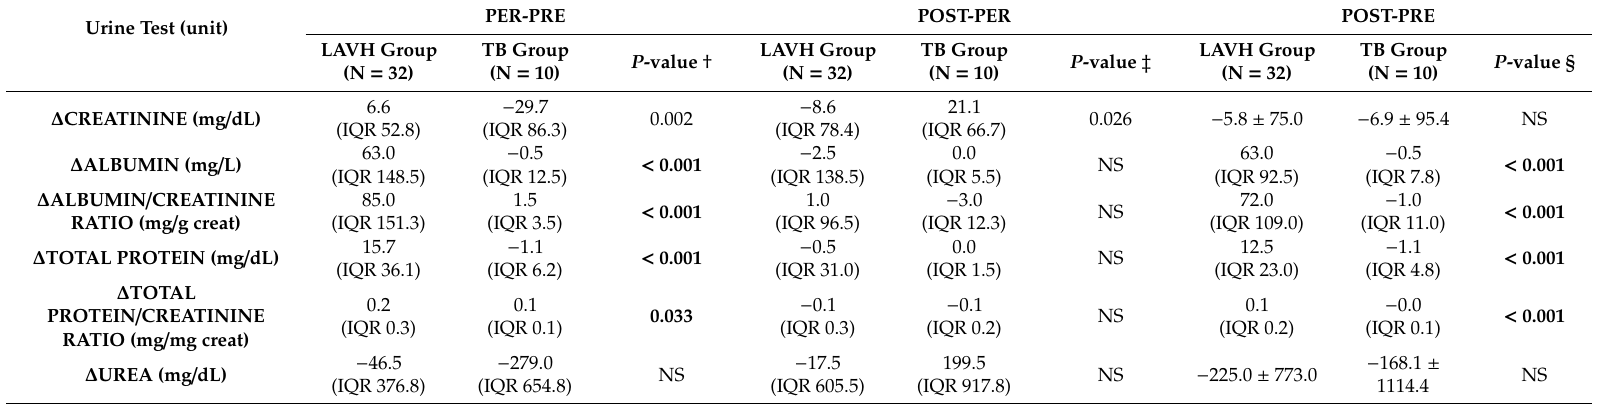
Table 3. Change in renal function parameters over time for both the intervention and the control